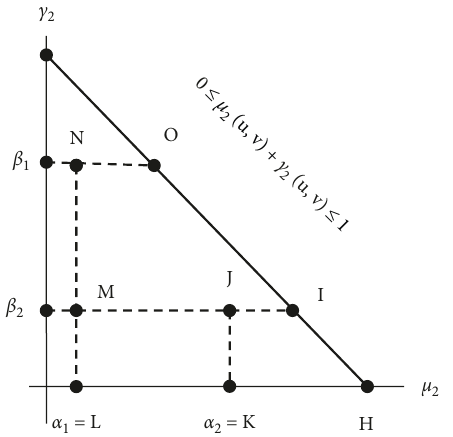
Figure 4: The comparison of E